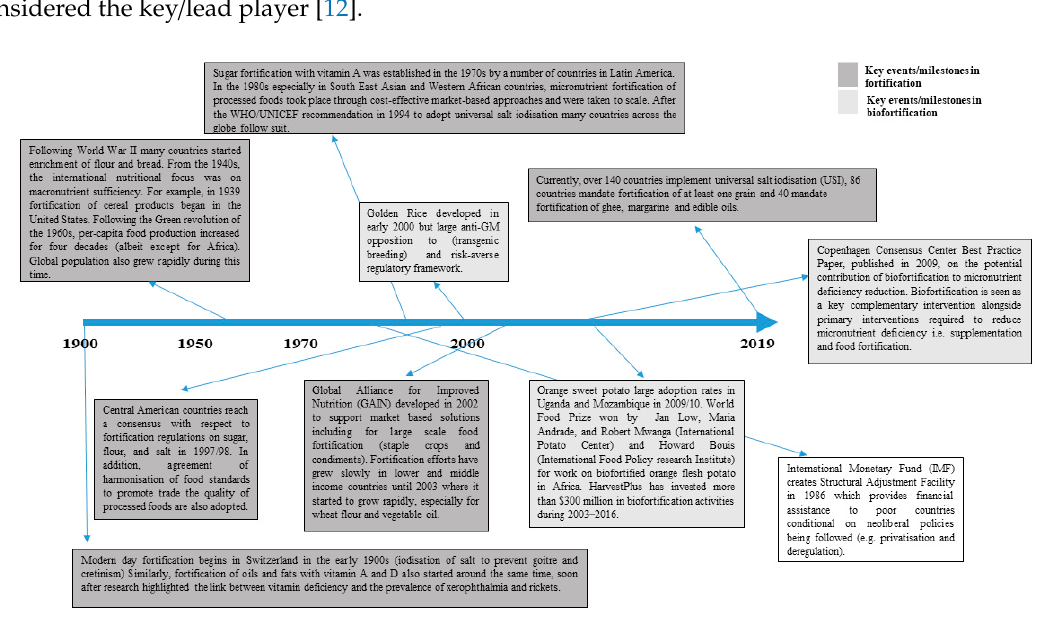
Figure 3. Timeline of key events in fortification, complementary foods, and biofortification Source: Adapted from [12,13,28,36,62,63].